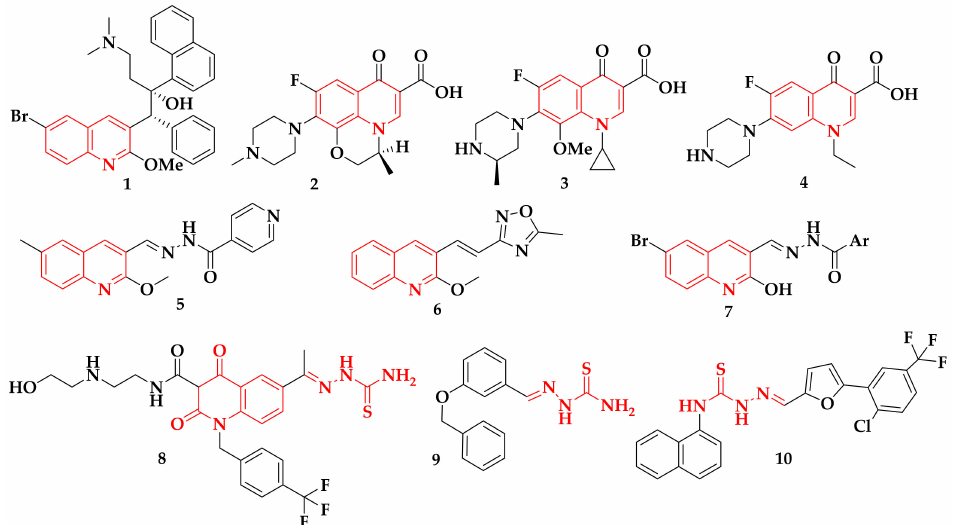
Figure 1. Structure of quinolinone-based anti-TB drugs: quinolines, quinolones, and thiosemicar- bazones, used as inhibitors of M. tuberculosis